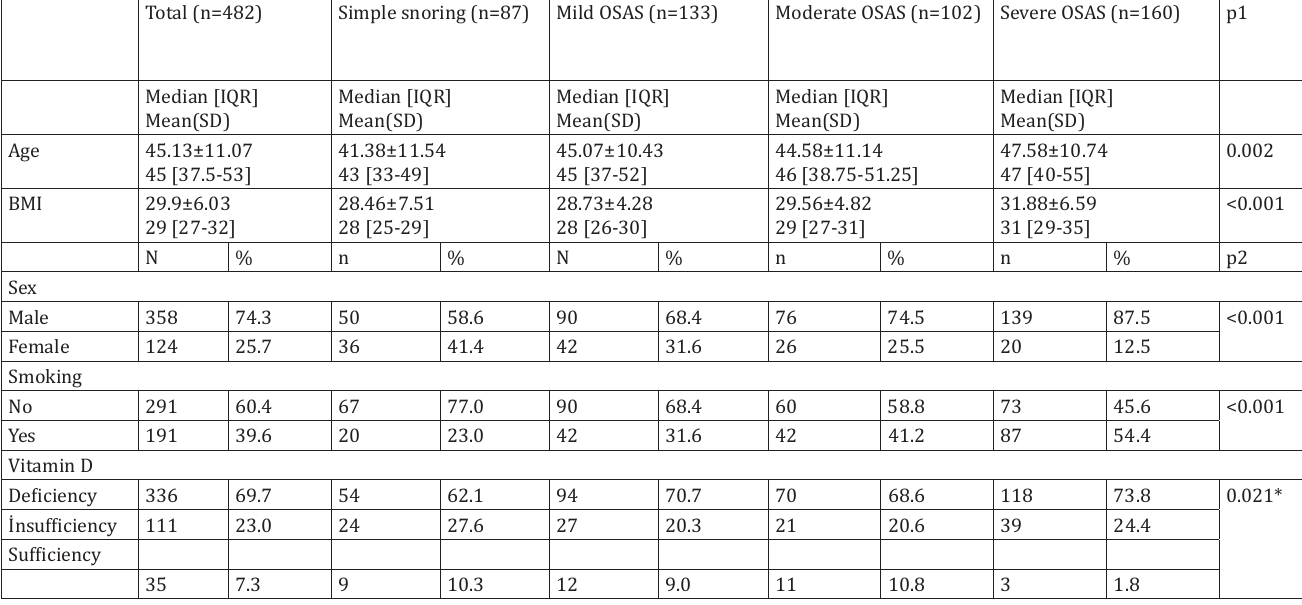
Table 1 Demographic, lifestyle and clinical characteristics of study subjects by severities of OSAS